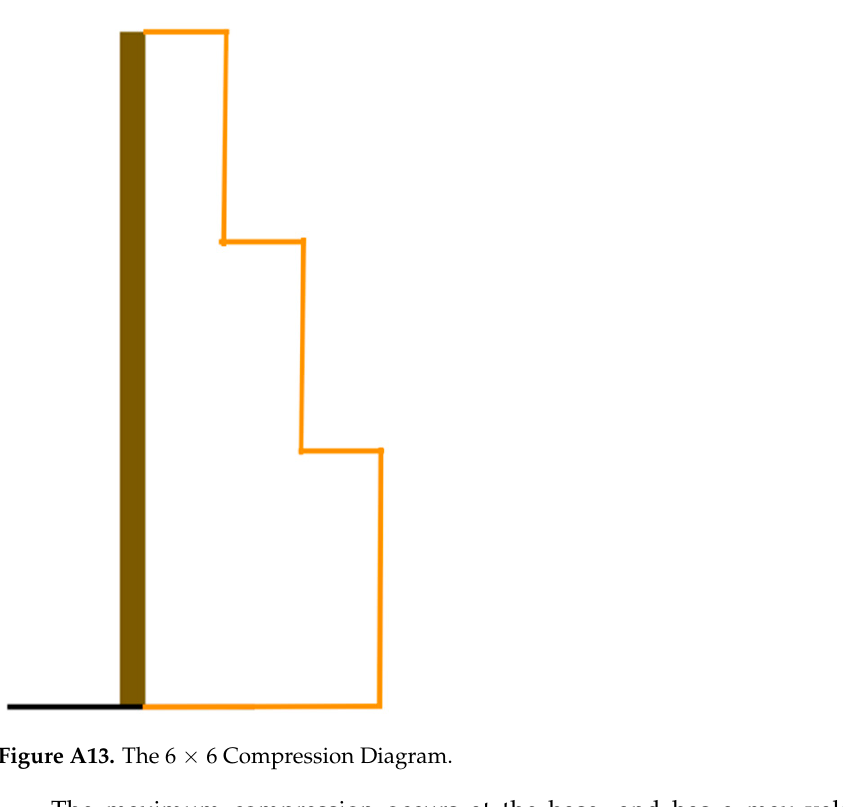
Table A1. Forces, deflections and stresses of structural